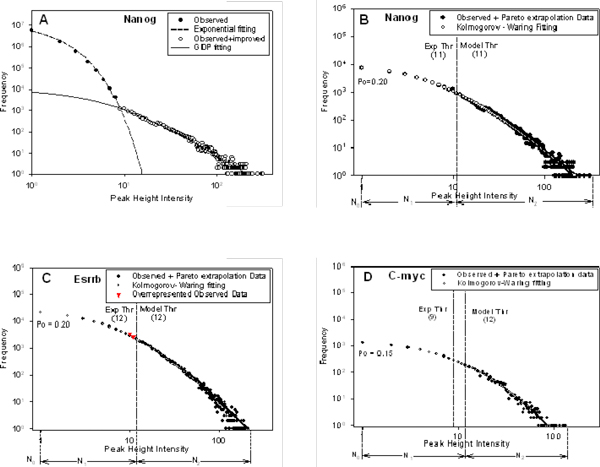
Observed and predicted statistics of TF--DNA BEs. A: Fitting and back extrapolation analysis for complete dataset. Decomposition of mixture model (1) for Nanog TF-DNA BEs is provided based on curve-fitting analysis of the model. Close circle: number of loci of ChIP-seq extended DNA cluster overlaps from 1 to 8 BEs. Open circle: number of loci of ChIP-seq extended DNA cluster overlaps from 9 to 73 (included) BEs. Noise-like (close circles) data fits well be exponential function with exponent parameter s = 1.05 ± 0.055 (p < 0.0001, t-test). The reliable set of TF BS (at >8 BEs) are equally well fitted by the left-side truncated GDP function (at k = 1.81 ± 0.15 (p < 0.001, t-test) and b = 8.00 ± 1.335 (p < 0.001, t-test)) as well as by K-W function (θ = 0.999, a = 6.618, b = 8.29; Table 3). Extrapolation curve predicts the number of Nanog TFBSs in the noise-enriched binding site fraction of the empirical distribution. B: Nanog TF-DNA BEs, C: Esrrb TF-DNA BEs and D: c-Myc TF-DNA BEs. B, C and D: K-W model fitting on the observed and extrapolated of double-truncated GDP data to calculate p0. Vertical dotted lines are representing qPCR-defined threshold and the threshold defined based on best-fit double-truncated GDP function. Triangle symbols show the observed over represented number of TFBSs in compare to best-fit GDP function. N0, N1 and N2 are the numbers of non-detected, potentially detected and high specific (reliable) TFBSs, respectively. More detail information about parameter values of GDP and K-W models presents in Additional File 3, 4, 5.